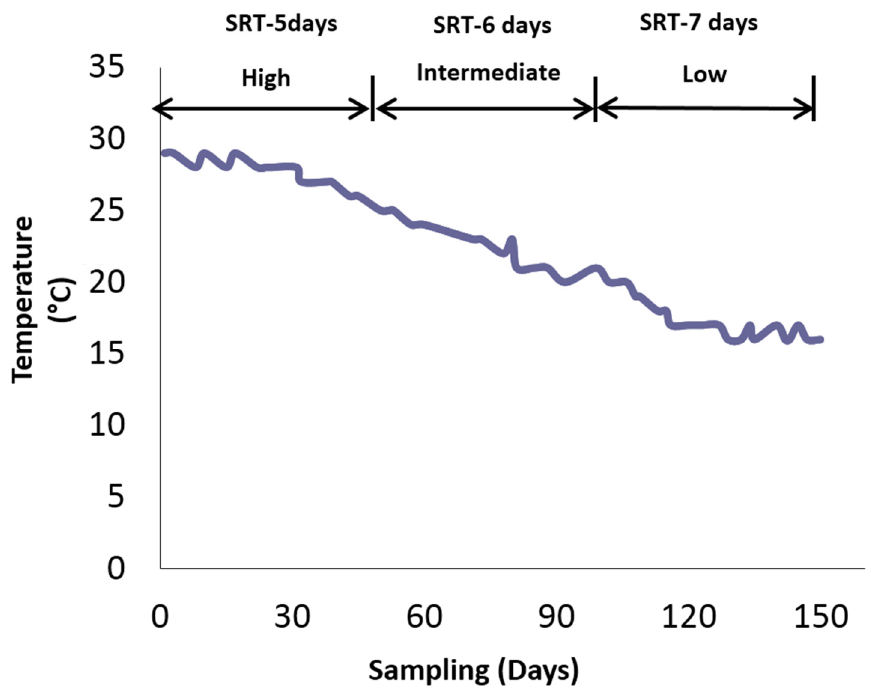
Figure 1. Temperature profile of wastewater treatment process (WWTP) from September 2012 to January